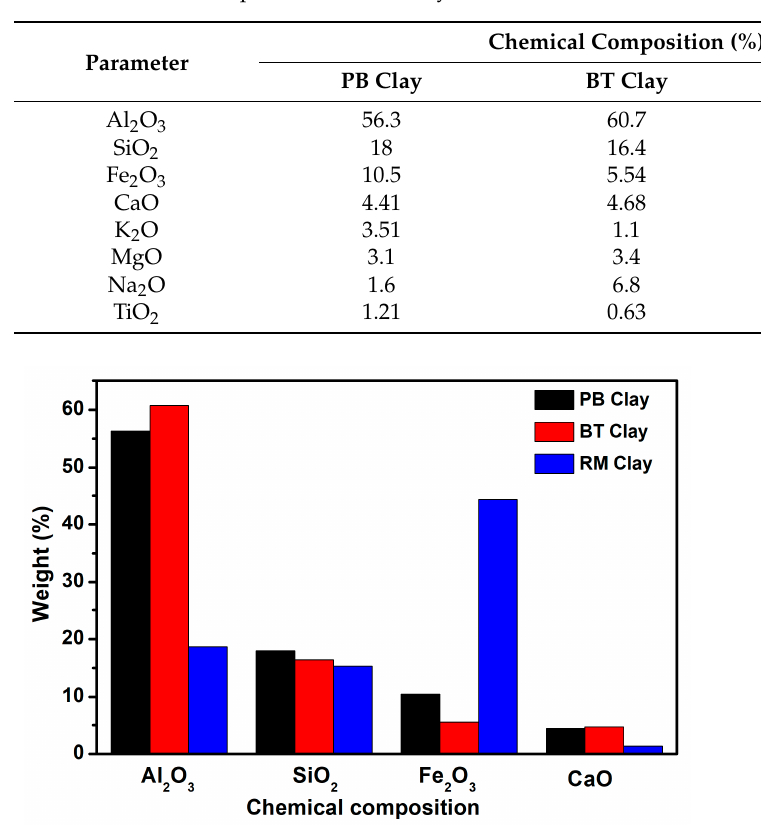
Figure 2. Major chemical constituents of the natural inorganic clays (NICs) adsorbents. Table 1. Chemical composition of NICs clay.